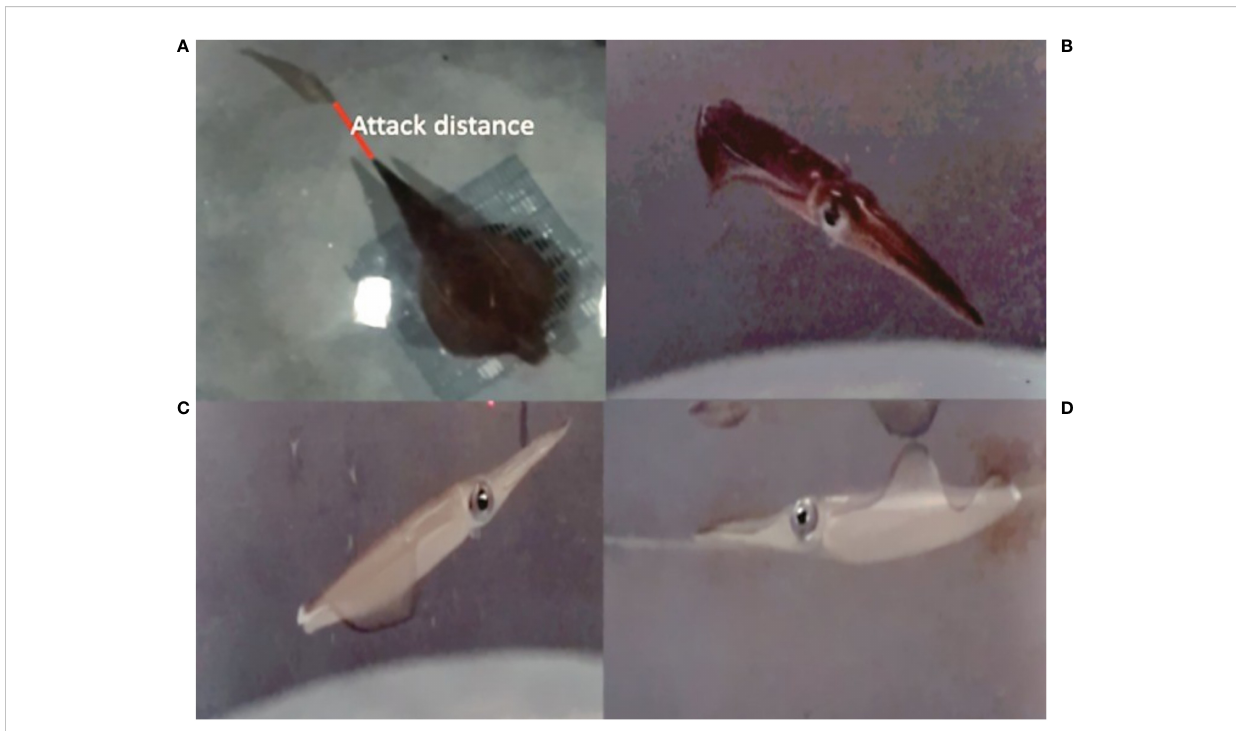
FIGURE 2 Southern calamari ( Sepioteuthis australis ) parameters observed in the experimental arena; (A) Attack distance and body pattern ‘ dark ’ , (B) ‘ downward pointing ’ attack position, (C) ‘ upward pointing ’ attack position, (D) ‘ horizontal arms ’ attack